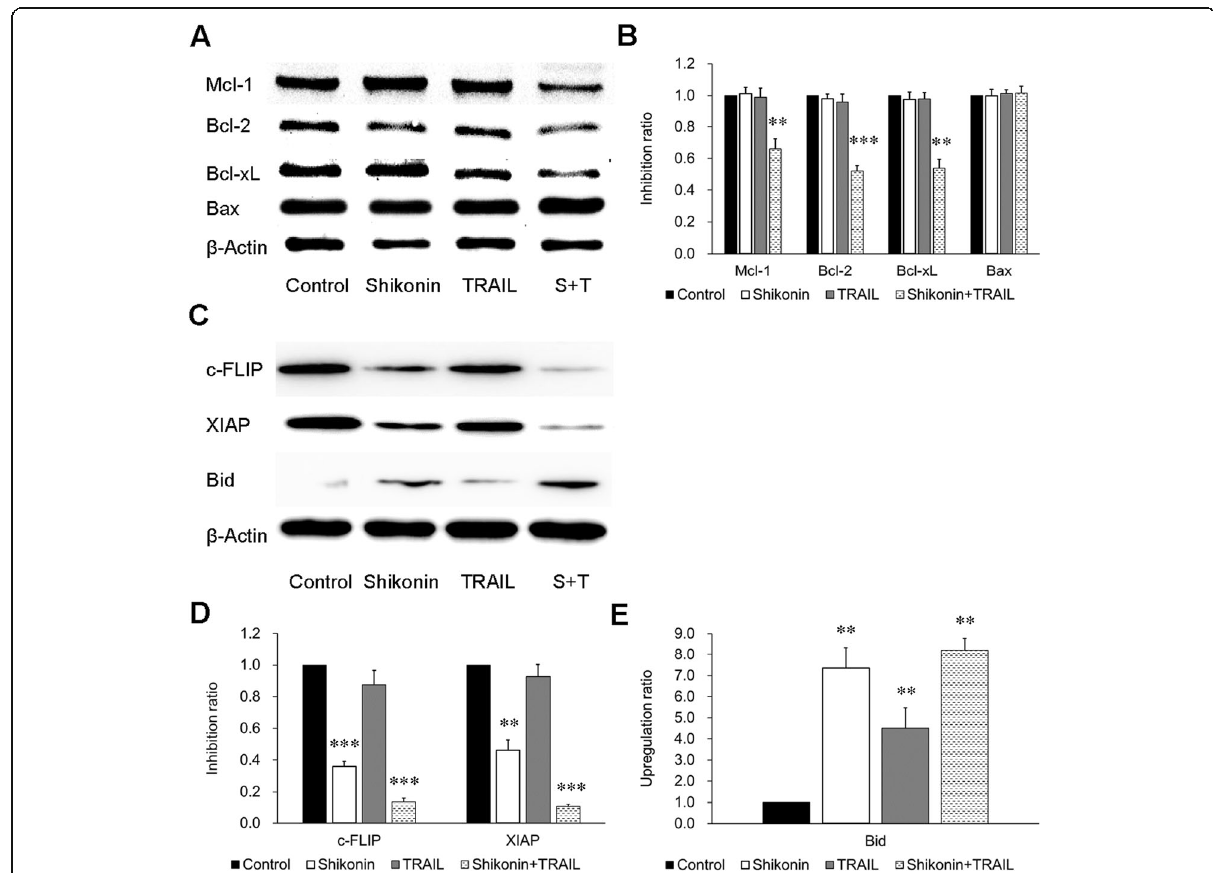
Fig. 3 Effect of shikonin and TRAIL on antiapoptotic and proapoptotic protein expression in A549 cells. a and c A549 cells were pretreated with shikonin (4 μ M) for 12 h and were then incubated with TRAIL (50 ng/ml) for another 12 h. Whole cell lysates were prepared and analyzed by Western blotting using the indicated antibodies. β -Actin was used as the loading control. b, d and e The data are presented as the means ± SDs of at least three independent experiments, and significant differences between the control group and other groups in each experiment are shown as ** p < 0.01 and *** p < 0.001. S + T: Shikonin +